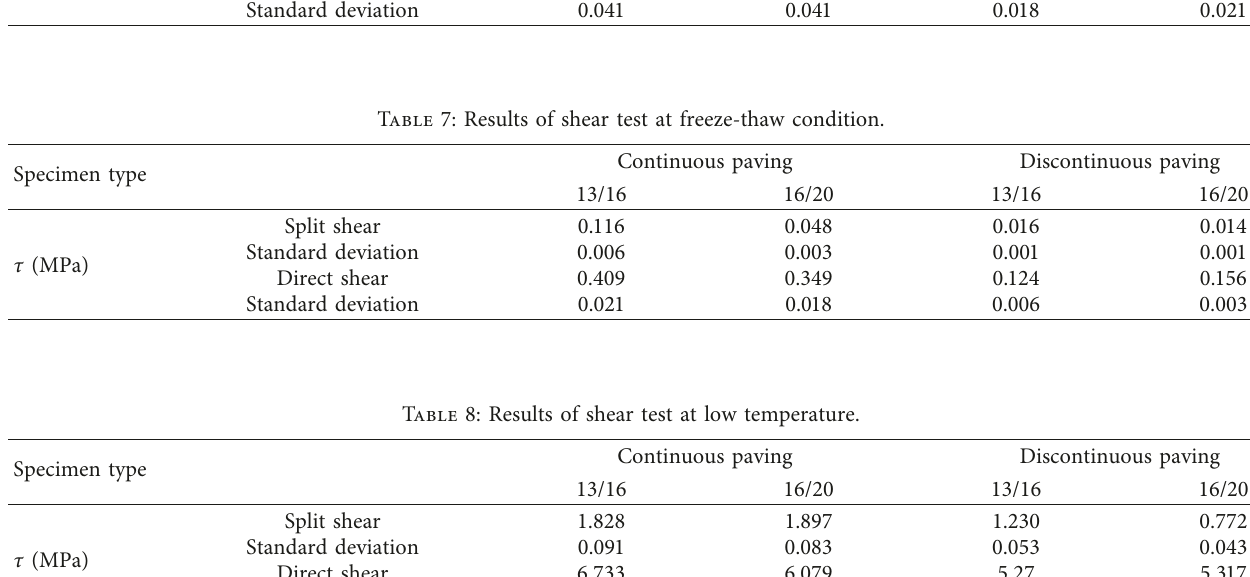
Figure 10, the split shear strength of continuous double-deck